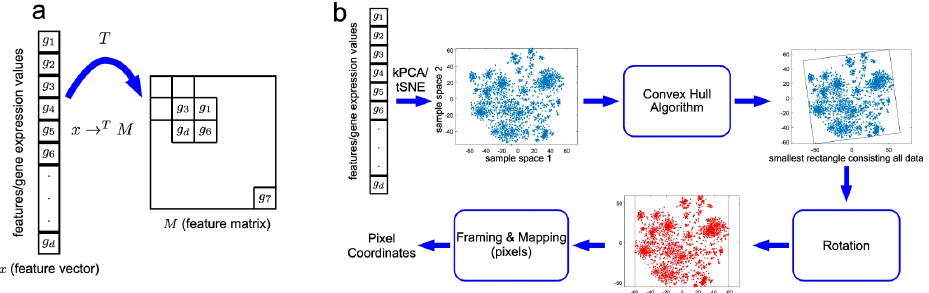
Figure 2. DeepInsight pipeline. ( a ) An illustration of transformation from feature vector to feature matrix. ( b ) An illustration of the DeepInsight methodology to transform a feature vector to image pixels. Image taken from DeepInsight